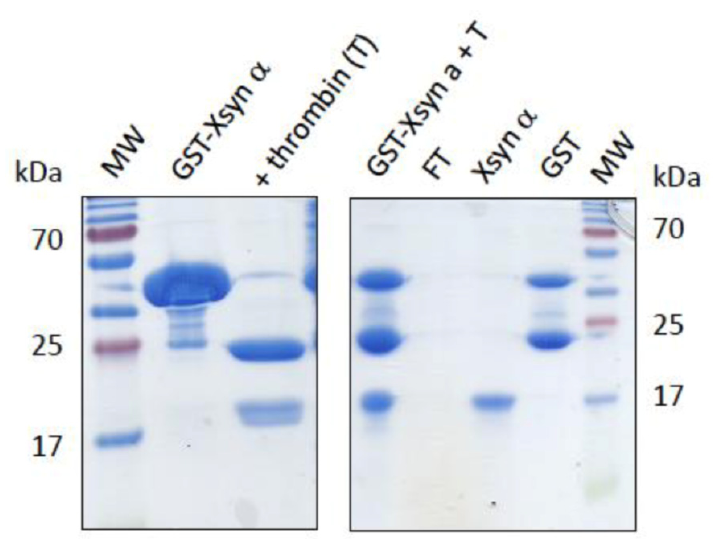
Figure 3. SDS-PAGE analysis of purified recombinant Xenopus α -syn (Xsyn α ). ( Left panel ), purified GST-Xsyn α before and after treatment with thrombin. ( Right panel ), GSH-Sepharose chromatogra- phy fractions: GST-Xsyn α treated with thrombin, flow-through (FT), Xsyn α and GST recovered in the wash and GSH-eluted fractions, respectively; MW: molecular weight markers.